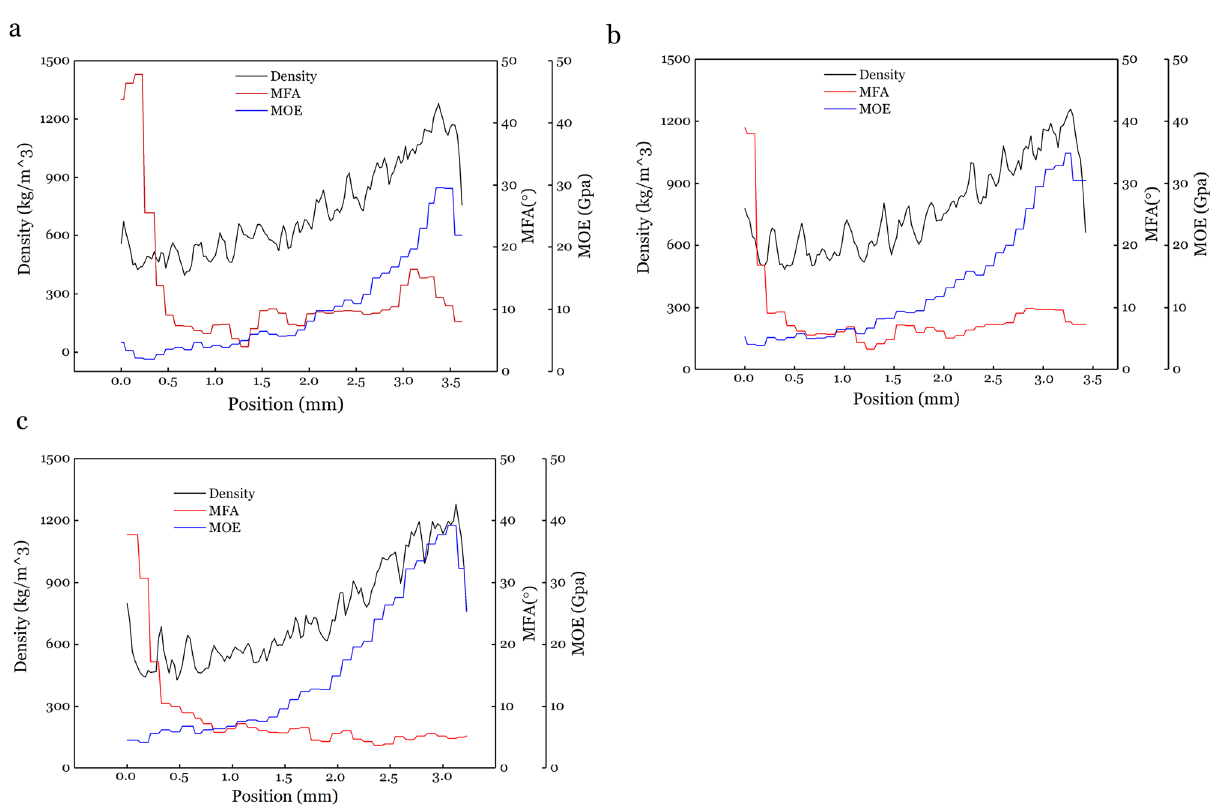
Figure 4. Radial distribution of density, MFA and MOE from YL to GL on ( a ) C sample, ( b ) N sample, and ( c ) T